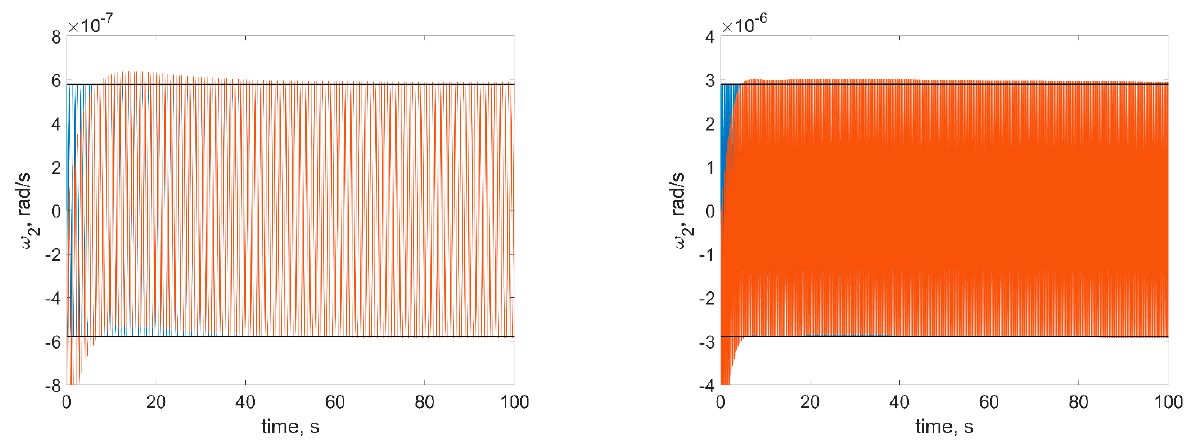
10 sec Ω = ( left ) and -1 = 10 s − 1 ( left ) and Ω